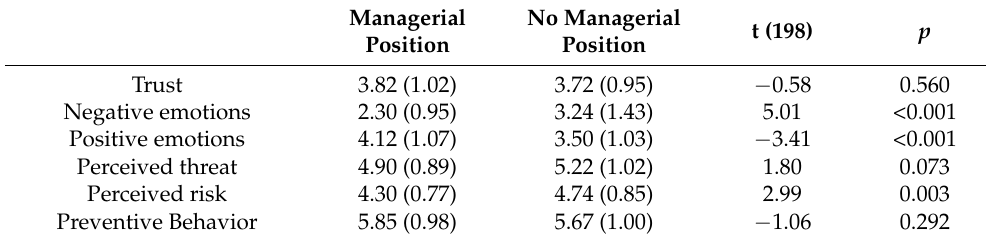
Table A2. t -tests for the study variables by managerial position ( N = 200).